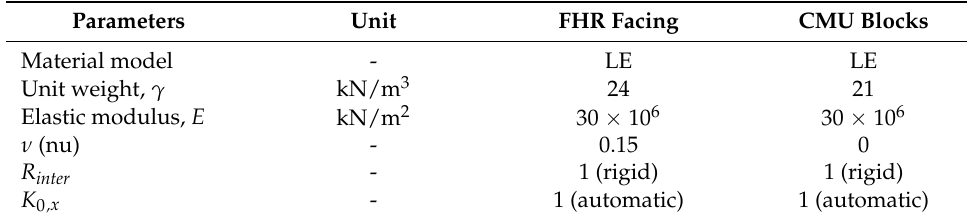
Table 2. Wall facing material input parameters.